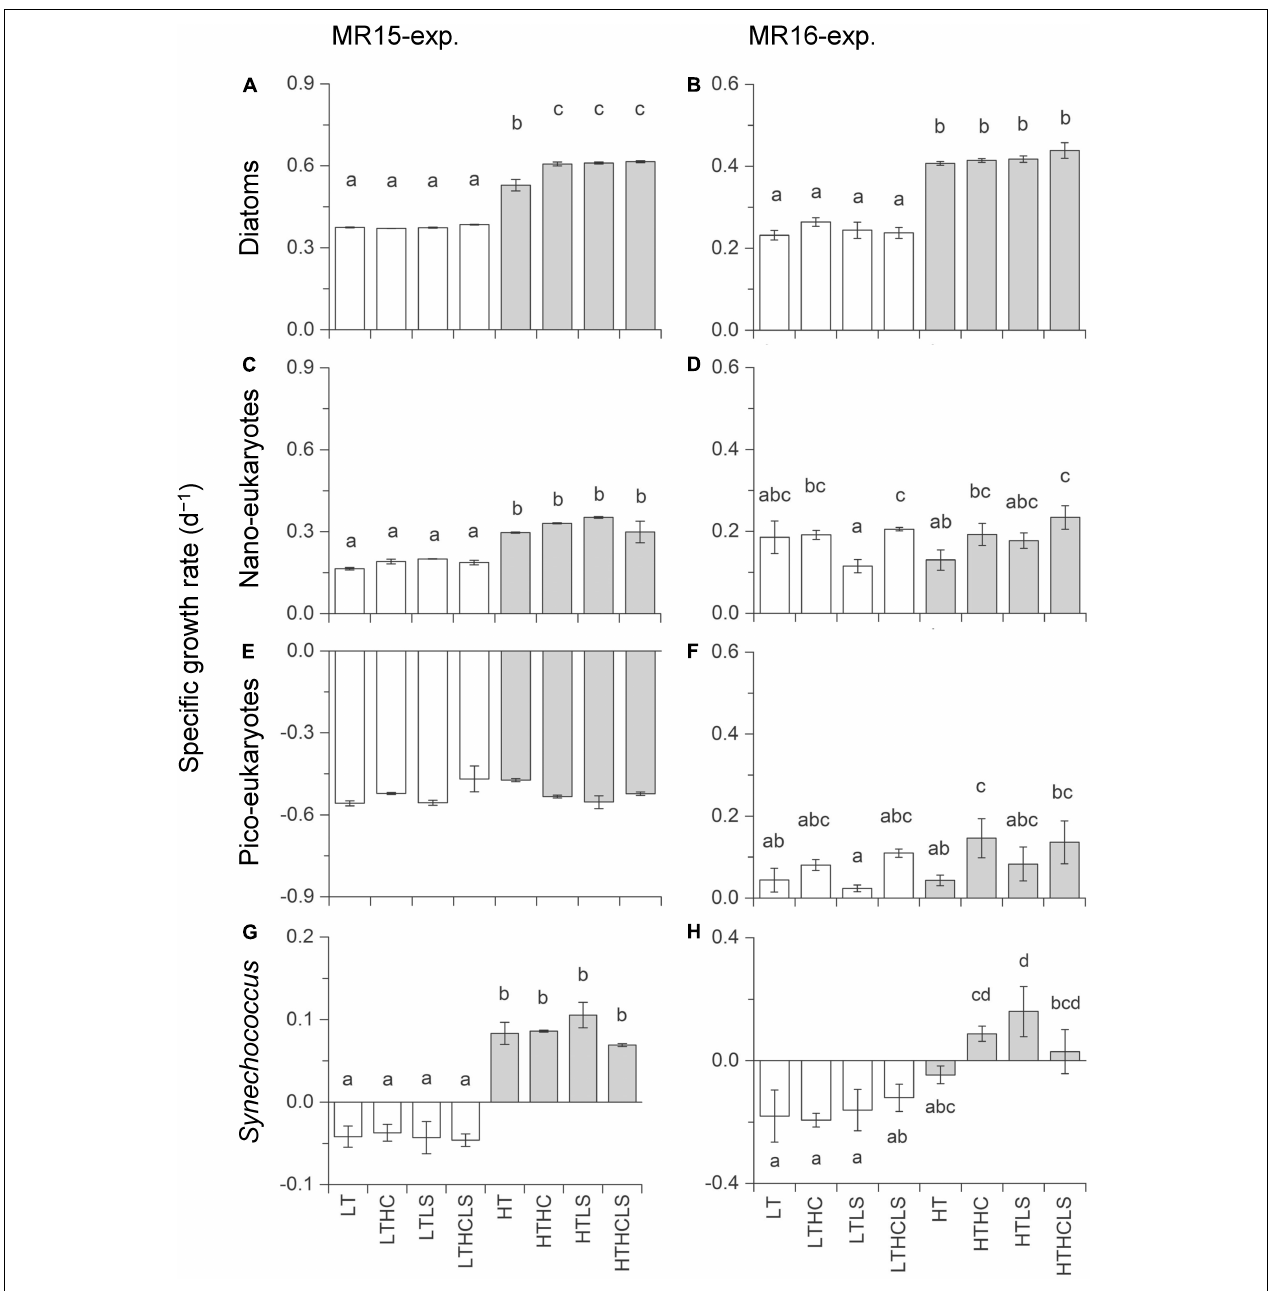
FIGURE 3 | Specific growth rate of (A,B) diatom biomass, (C,D) eukaryotic nanophytoplankton, (E,F) eukaryotic nanophytoplankton, and (G,H) Synechococcus . Left and right panels represent the MR15-exp. and the MR16-exp., respectively. Letters above the bars represent statistical results of groups according to the Tukey–Kramer